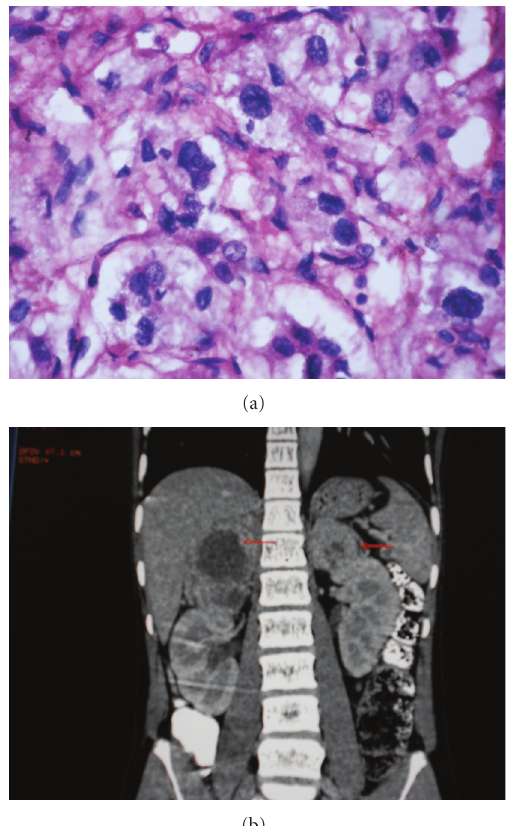
Figure 1: (a) Microscopic view of the resected mass. (b) CT scan Abdomen showing